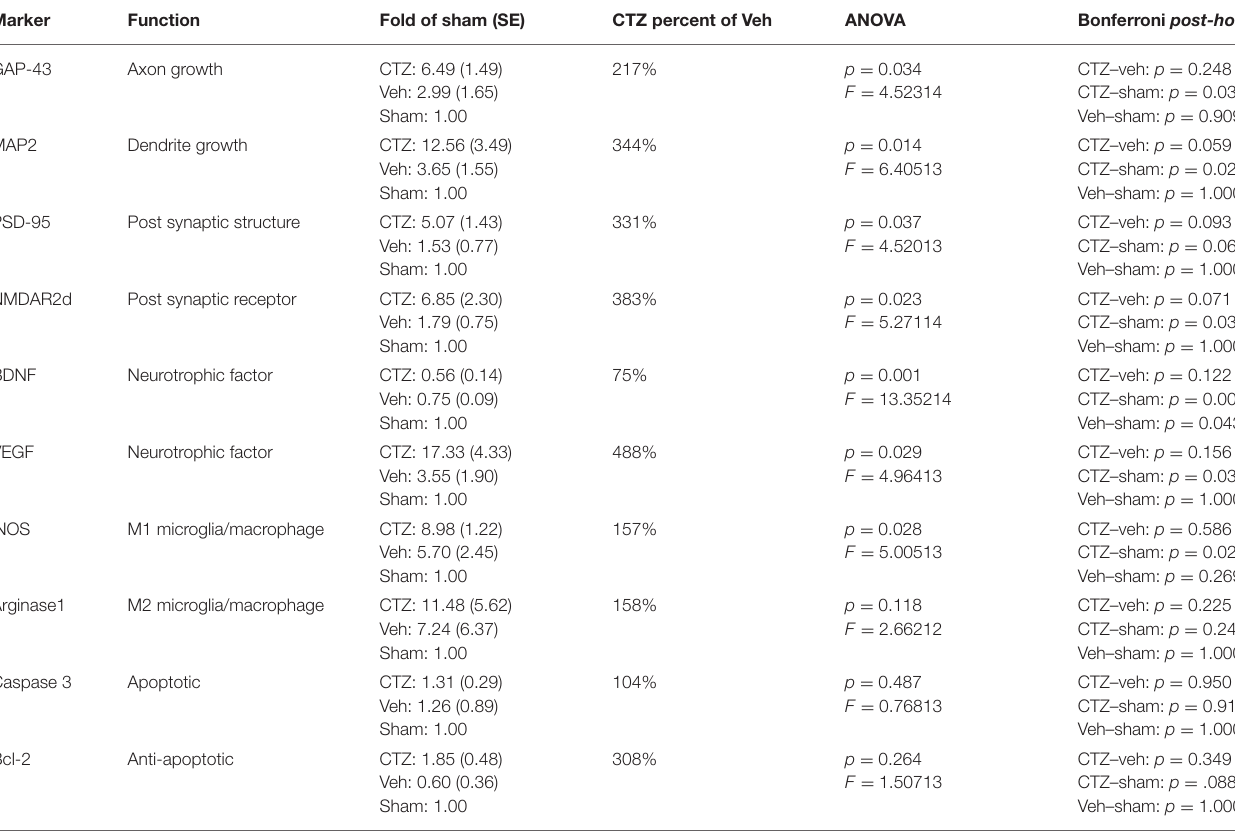
TABLE 1 | Gene expression levels after injury and